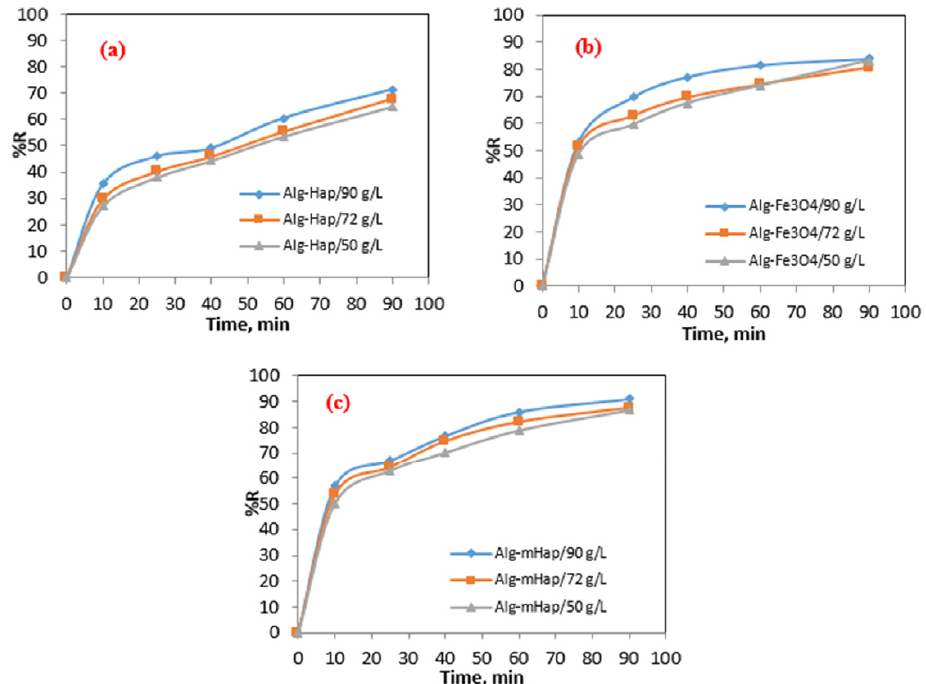
Fig. 8. Effect of catalyst amount on cefixime removal (a) Alg-Hap, (b) Alg-Fe